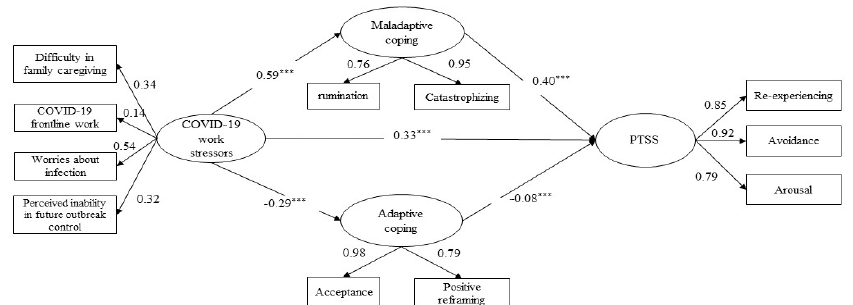
Figure 1. The structural equation modeling of the association between COVID-19 work-related stressors and PTSS via adaptive and maladaptive coping. Note: Latent variables are shown in ovals and observed variables in rectangles. Standardized coefficients are presented (*** p < 0.001.). For simplicity, the significant background covariates (i.e., marital status) of outcomes and error covariance are not presented. Abbreviations: PTSS, posttraumatic stress symptoms.